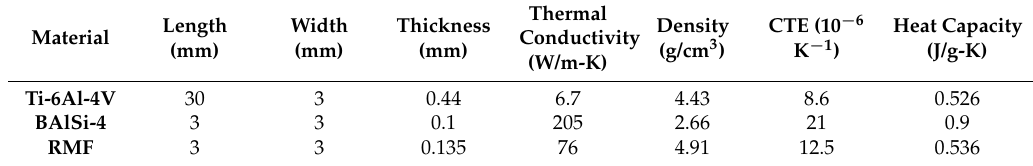
Table 2. Layer-wise Additive Manufacturing Predictions and Simulations (LAMPS © ) simulation